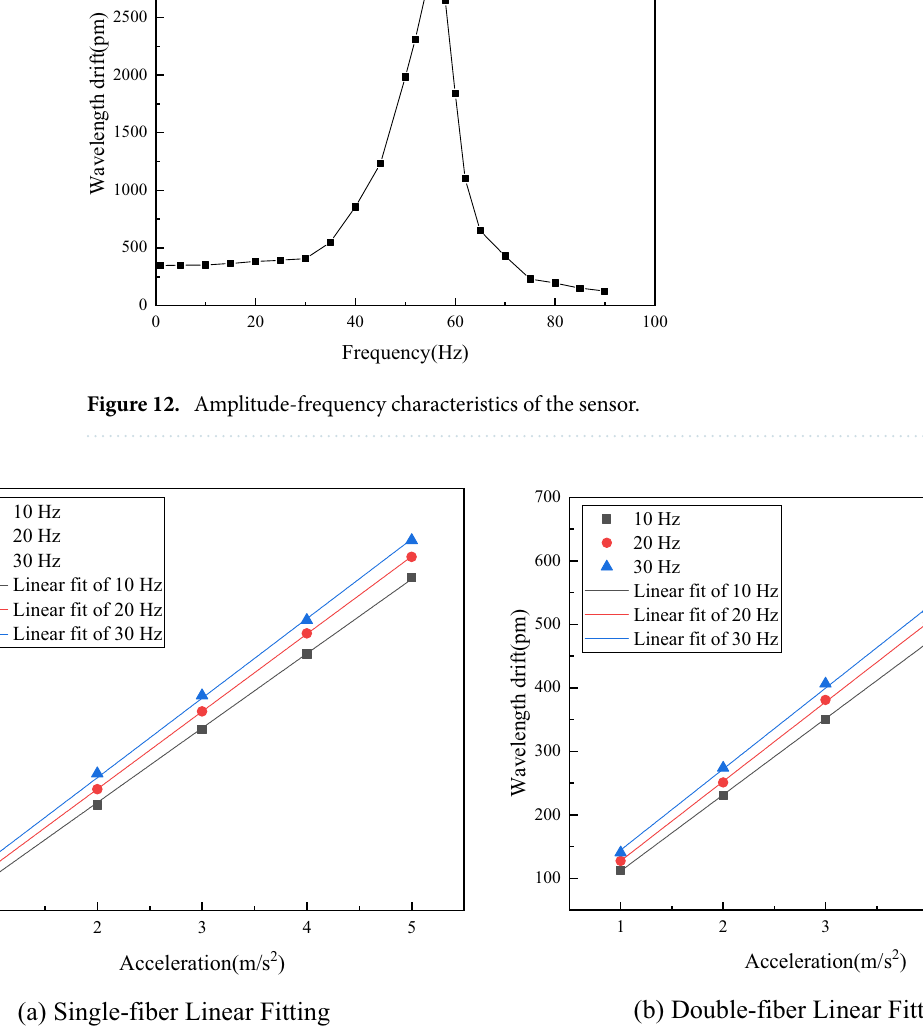
Figure 13. Sensor linear fitting